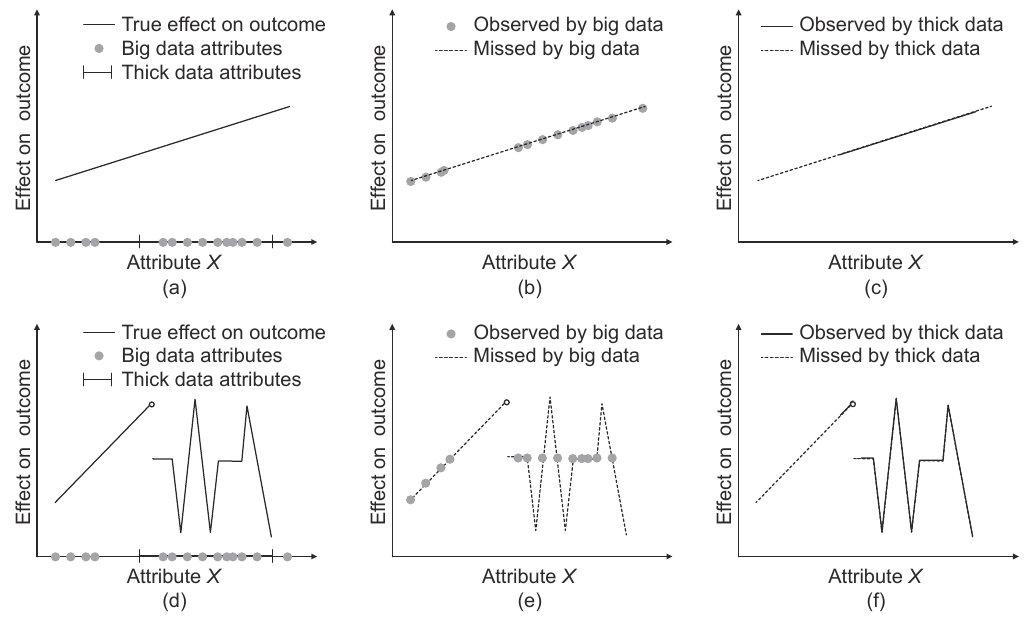
Fig. 3 Trend of how big and thick data can fail to capture